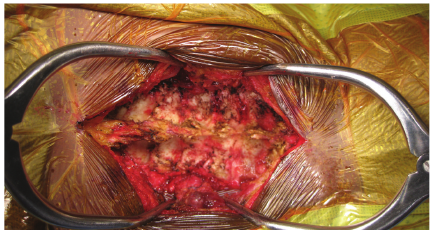
Figure 3: Intraoperative photo showing laminoplasty exposure. Following midline dissection along the avascular subperiosteal plane, paraspinal muscles are retracted laterally and the spinous processes, lamina, and medial aspect of the facets should be com- pleted denuded of soft tissue.